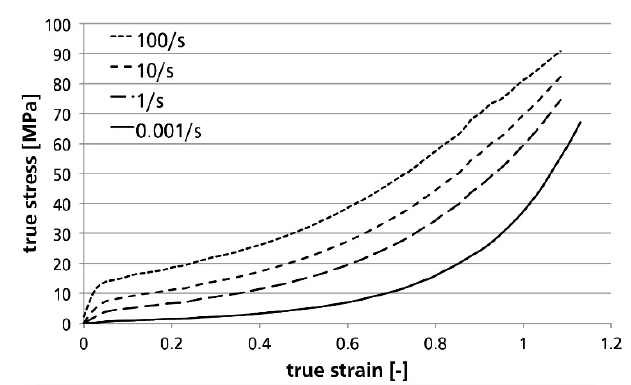
Fig. 3 Uniaxial tensile tests on PVB at 22°C: true stress vs. true strain at constant strain rates (Fig. from Schneider et al., 2012).